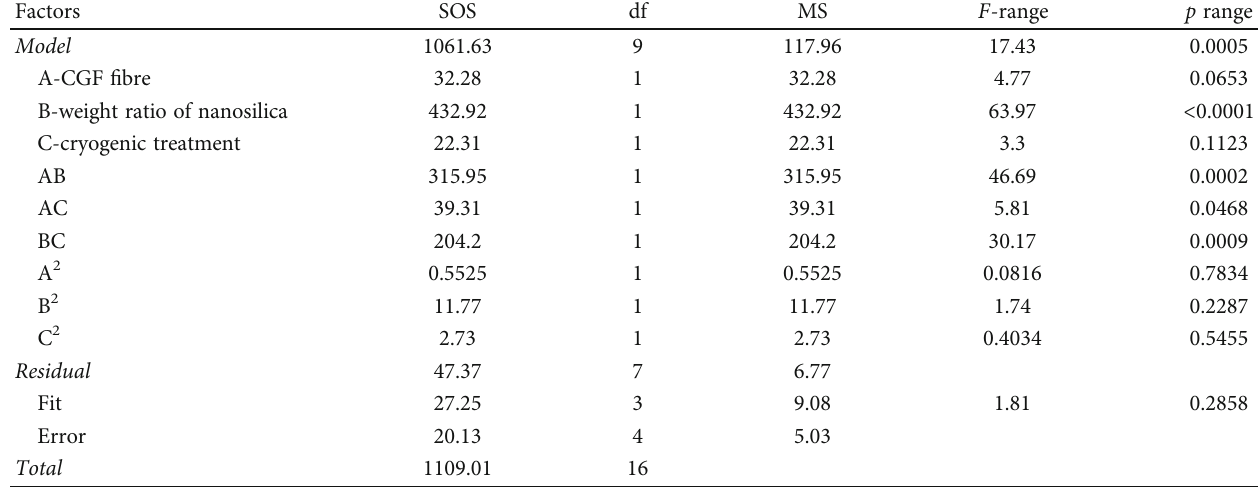
Table 5: ANOVA for impact